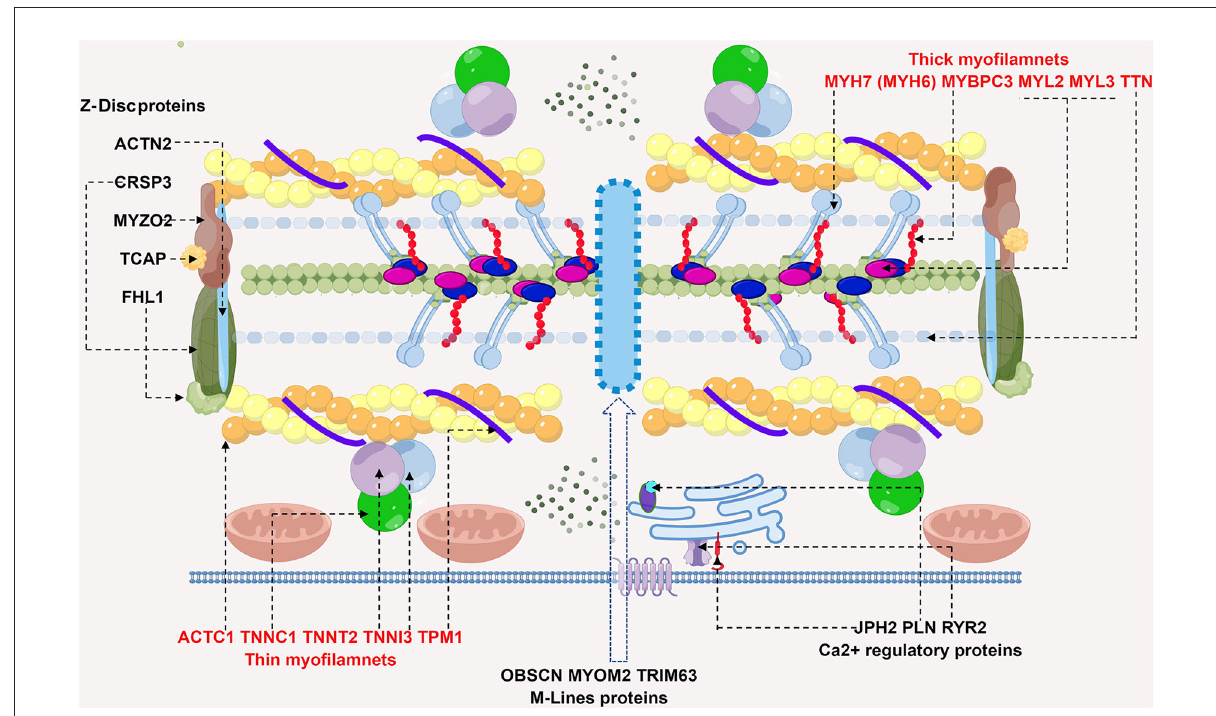
FIGURE1 Schematic diagram of potential sarcomere gene mutations involved in HCM. HCM is mainly a disease of sarcomere proteins, which are comprised of thick and thin filaments, Z-Disc, M-lines and calcium regulatory proteins. Shown in the diagram are recognized genes affected in HCM, dashed arrows point to the corresponding proteins. Thick filaments are comprised of MYH7 (myosin heavy chain 7) and MYBPC3 (myosin binding protein C3), MYL2/3 (myosin light chain 2/3) and TTN (titin). Gene screening in HCM patients reach to mutations in MYBPC3 and MYH7, most commonly. ACTC1 (cardiac α -actin 1), TNNT2 (cardiac troponin T), TNNI3 (cardiac troponin I), TNNC1 (cardiac troponin C), and TPM1 ( α -tropomyosin) collectively constitute thin filaments. Rare causes of HCM by gene mutations in Z-disc, M line proteins and calcium regulatory proteins are also depicted. Abbreviations: ACTN2, α -actinin 2; CSRP3, cysteine and glycine rich protein 3; MYOZ2, myozenin 2; TCAP, TTN capping protein; FHL1, four and half LIM domain1; OBSCN, obscurin; MYOM2, myomesin 2; TRIM63, tripartite motif containing 63; PLN, phospholamban; JPH2, junctophilin 2; RyR2, type 2ryanodine